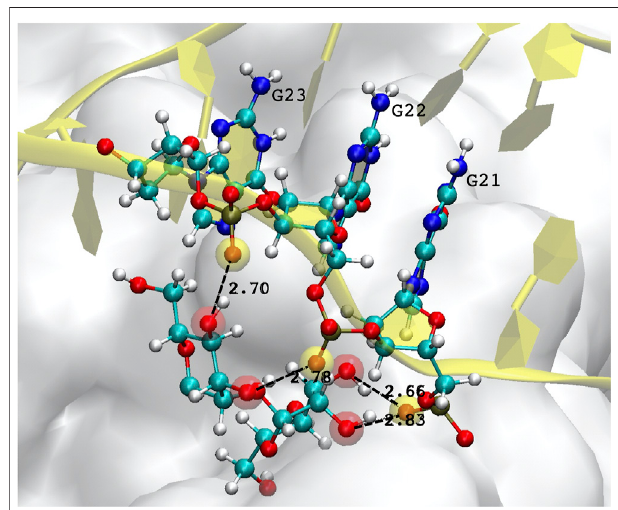
FIGURE 6 | Example of hydrogen bonds formed by the DNA aptamer interacting with the glycans of the S-protein. In this case, three consecutive guanines form four bonds with two mannoses. Atoms participating in the H-bond are highlighted by a transparent red (mannose hydroxyl oxygen) or yellow sphere (DNA backbone